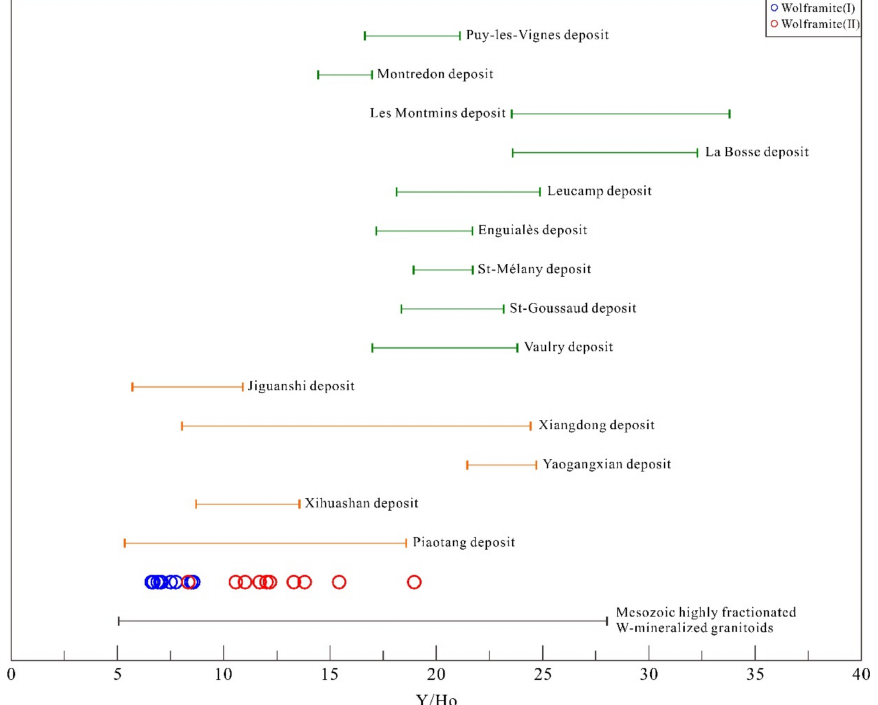
Figure 18. Y/Ho ratios for wolframite and W-mineralized granitoids. Data of wolframite from the Piaotang, Xihuashan, Yaogangxian, Xiangdong, and Jiguanshi deposits in South China are listed in Table S1. Data of wolframite from the Vaulry, St-Goussaud, St-M é lany, Enguial è s, Leucamp, La Bosse, Les Montmins, Montredon-Labessonni é , and Puy-les-Vignes deposits in French Massif Central are listed in Table S1. Data of Early Mesozoic W-mineralized granitoids in NE China are listed in Supplementary Material Table